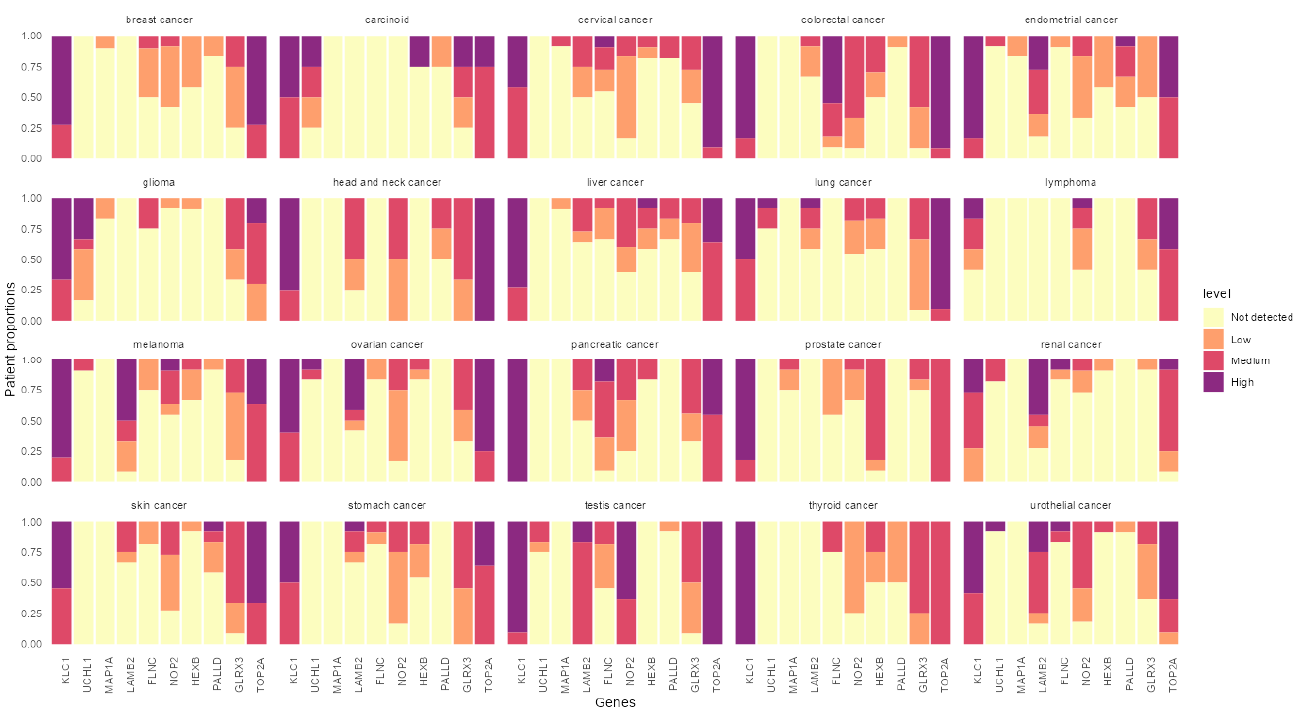
antigens derived from p53-R175H and p53-R273H mutants and common to both HLA fractions (Pan-HLA and HLA-A2) were checked for their normal tissue expression. Heatmap showing the expression levels of each protein in normal cells. The purple, red and orange colors indicate very high to low levels of expression, pale yellow represents no expression detected, and white represents no data available in the corresponding histology in Human Protein Atlas.